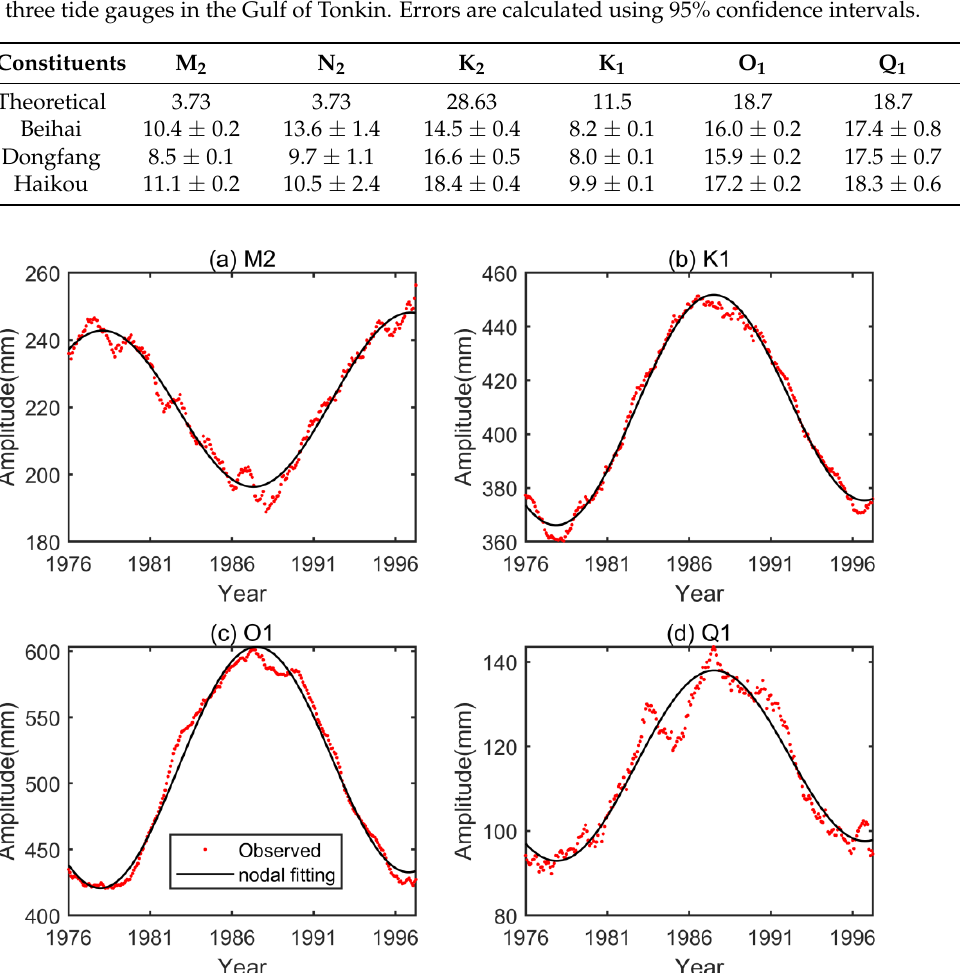
Table 4. Actual 18.61-year nodal modulations and their errors of tidal amplitudes of main constituents at three tide gauges in the Gulf of Tonkin. Errors are calculated using 95% confidence intervals.